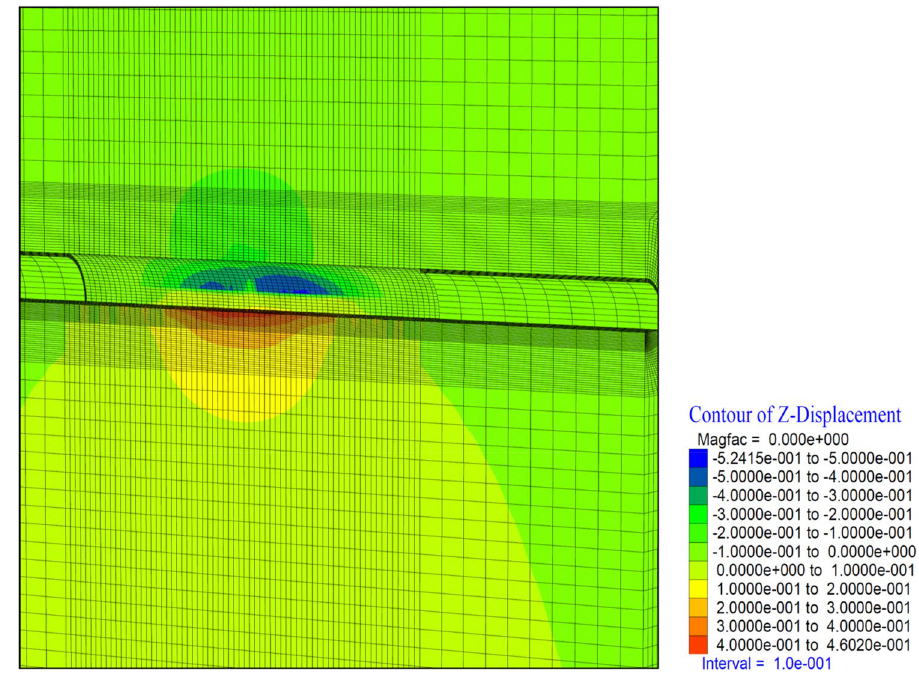
Figure 29. Z displacement in stage 74.